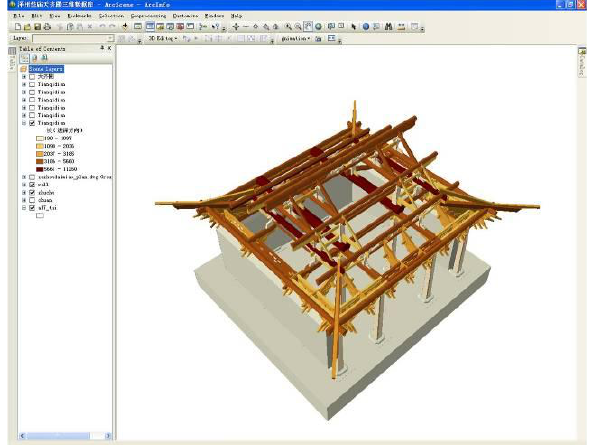
Figure 17 Statistics results of wood members length of Tianqi Shrine